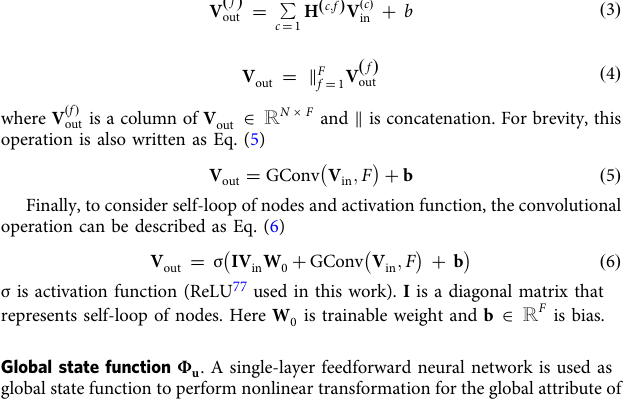
Supplementary Table 15. Trading off the impact sensitivity and the explosion heat, we fi nally select the coformer 8 (1-methyl 4- nitropyrazole) to conduct the cocrystalization experiment (see Supplementary Methods for details). We mingle the coformer 8 and CL-20 with anhydrous methanol. After slowly